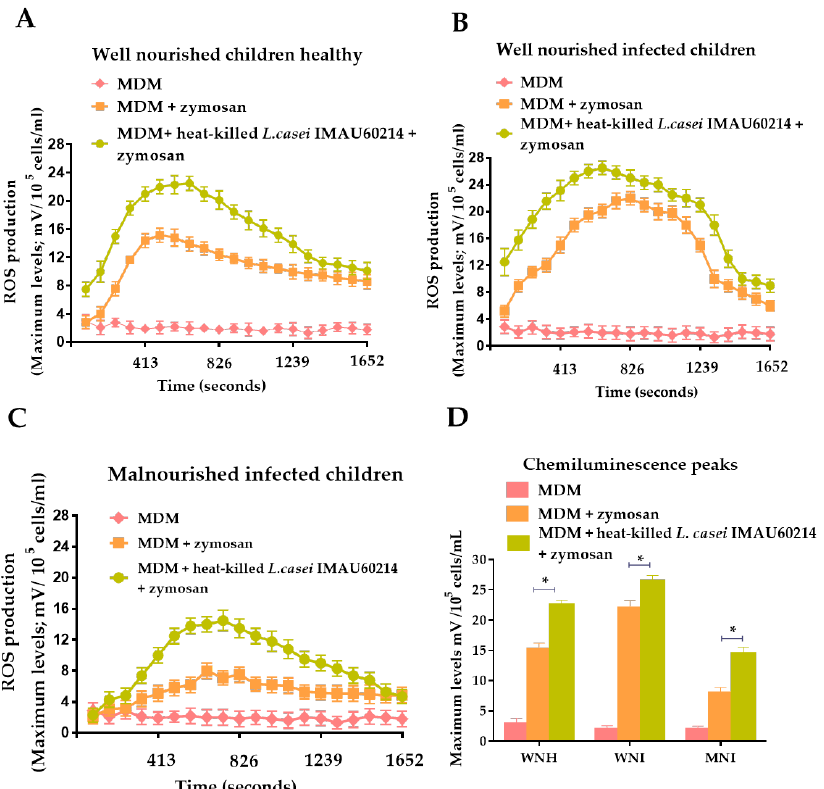
Figure 1. Effect of heat-killed L. casei IMAU60214 on reactive oxygen species (ROS) secretion by monocyte-derived macrophage (MDM) cells from well-nourished healthy (WNH), well-nourished infected (WNI) and malnourished infected (MNI) children. MDM cells 5 × 10 5 / mL in Roswell Park Memorial Institute (RPMI)-1640 / 10% FBS were pre-treated with heat-killed L. casei IMAU60214